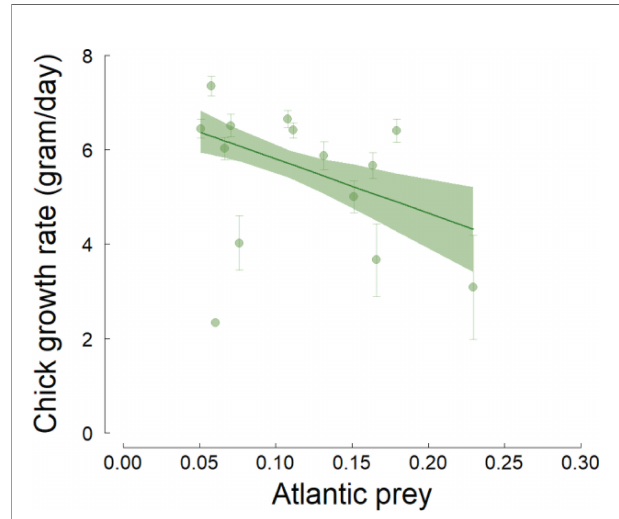
FIGURE 5 | Effect of the average annual proportion of Atlantic prey in the little auk chick diet on chick growth rate in Hornsund. The chick growth rate represents the number of grams per day gained by the chicks during their fi rst 16 days of life (i.e. when the growth is linear). The lines are the regression lines from linear models and the shaded areas represent the bootstrapped 95% con fi dence intervals of the predicted values. Error bars represent the standard errors of the average chick growth